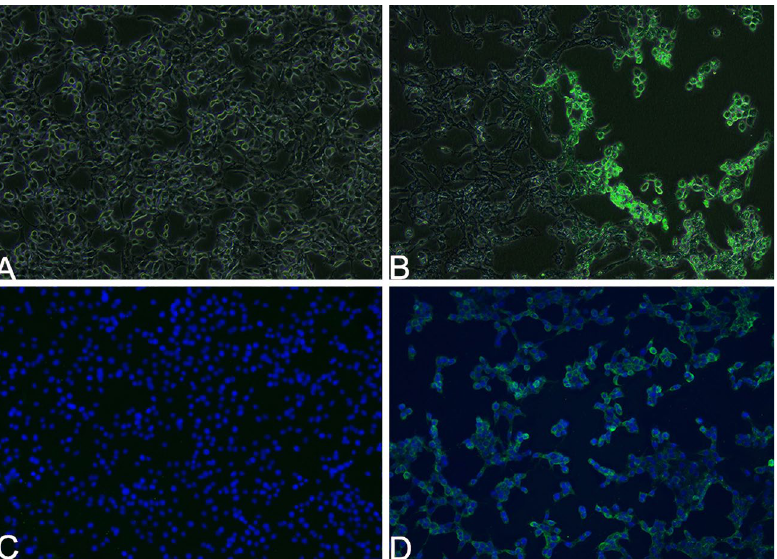
Figure 5. Isolation and identification of Feline herpesvirus type-1 (FHV-1) SL/QH/2019 strain. ( B ) FK81 cells inoculated with nasal swab supernatant of Case 2 for 36 h and show an obvious cytopathic effect (CPE), characterized by a round shape, pyknosis, fusion and aggregating like “fleece-pulling.” ( D ) The positive signal (green) of FHV-1 located in the cytoplasm of FK81 cells by indirect immunofluorescence. ( A ) and ( C ) Mock controls. ( A ) and ( B ) are merging image of bright-filed and fluorescence. ( C ) and ( D ) The nucleus is stained with DAPI and presents blue. FK81 cells from virus-free served as a negative control (×100). Captured by Nikon TS2-FL fluorescence microscope and NIS-Elements D Ver5.01.00. www. micro scope. healt hcare. nikon. com/ produ cts/ softw are/ nis- eleme